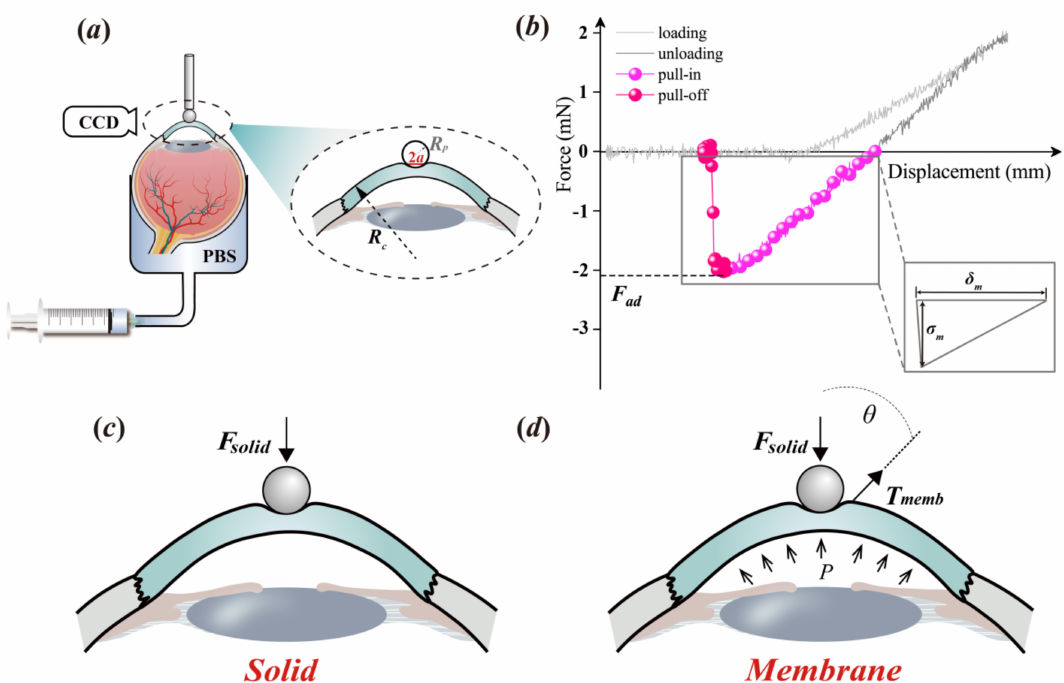
Figure 1. Schematic illustrations for determining corneal adhesion: ( a ) Sketch of the pull-off test in which R p and R c , respectively, represent the radii of the punch and the cornea, and a is the related contact radius; ( b ) an example of the experimental data; ( c , d ) illustration of the related analytical theory in which F solid represents the adhesion force balanced by the Hertz and the Knedall terms, and T memb represents the surface tension related to the membrane